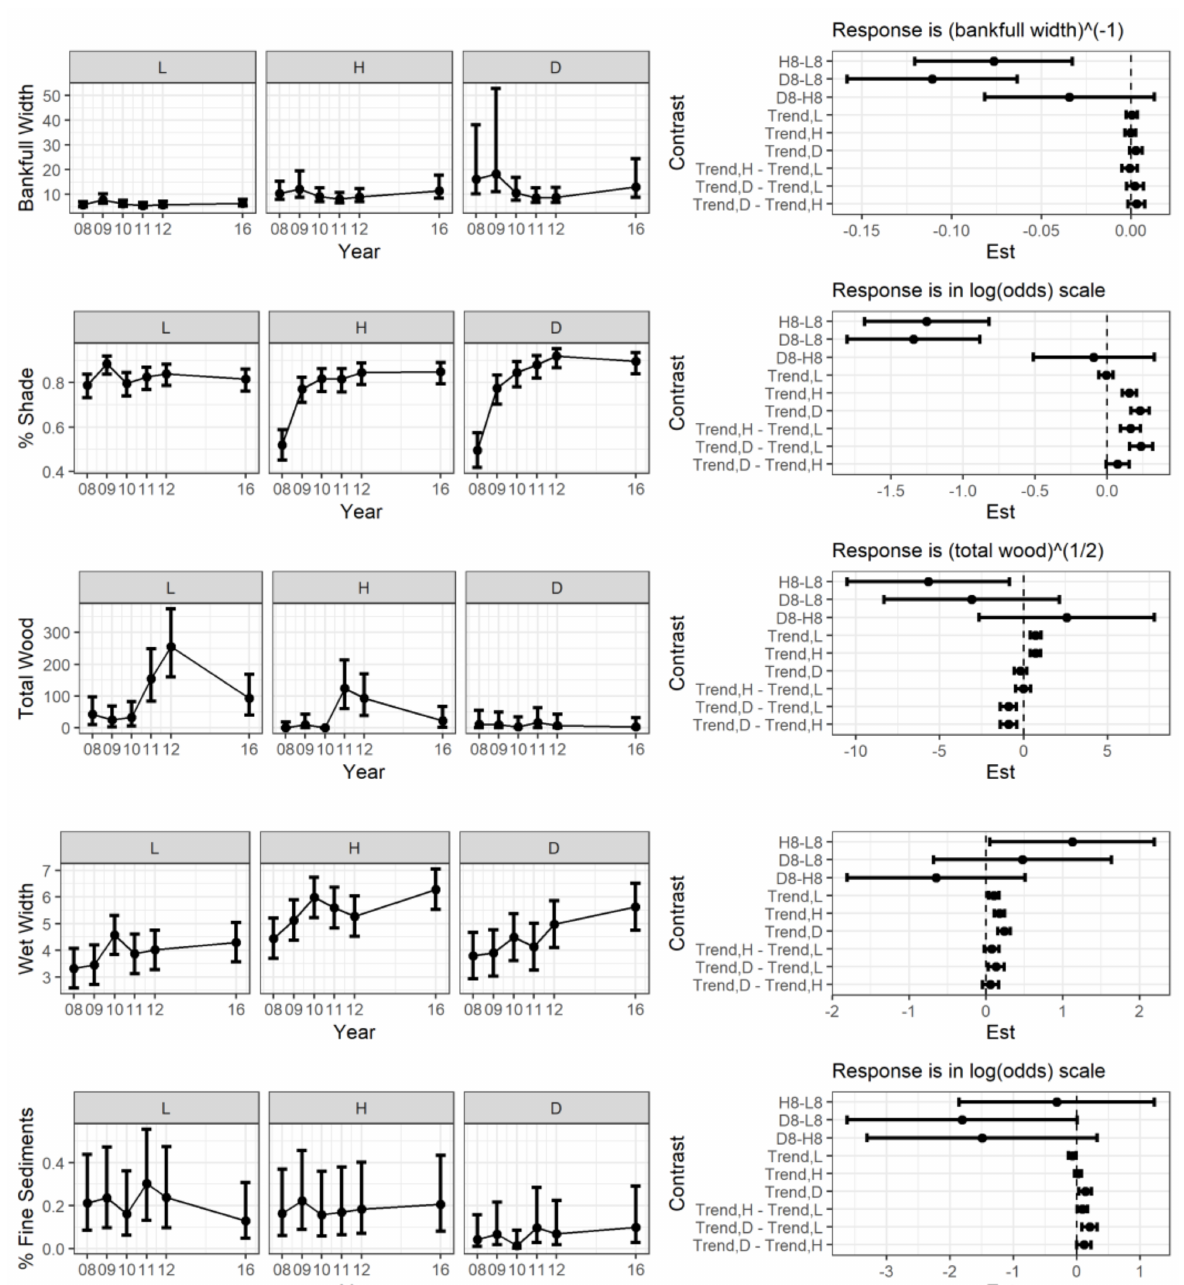
Figure 5. Estimated marginal means with 90% C.I.s of in summer of five physical characteristics after 2008 to 2016 at low flood ( L ), high flood ( H ), and debris flow ( D ) disturbance categories (left) and sets of contrasts differences in 1st year response (1–3), differences in trend through time (4–6), and of differences in trend between categories (7–9) (right